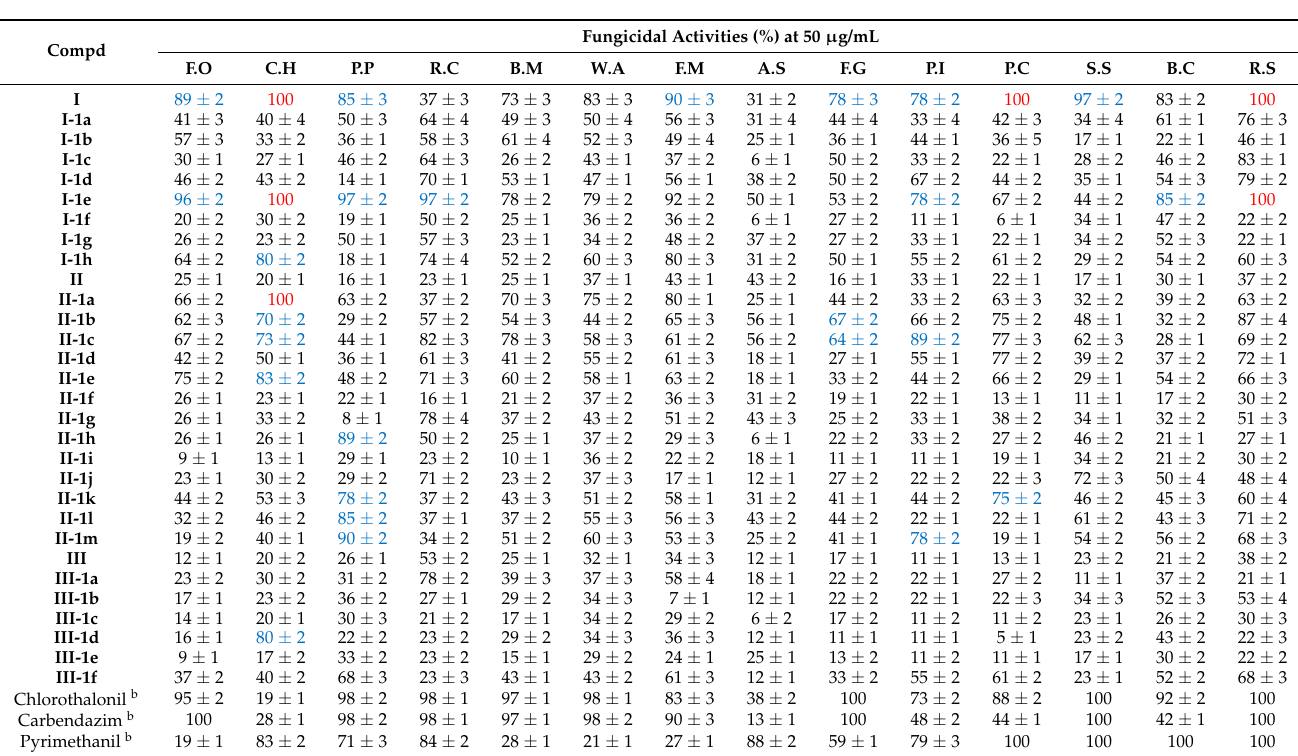
Table 1. In vitro fungicidal activities of compounds I , II , III , I-1a – I-1h , II-1a – II-1m , III-1a – III-1f , chlorothalonil, carbendazim and pyrimethanil against 14 types of fungi a .